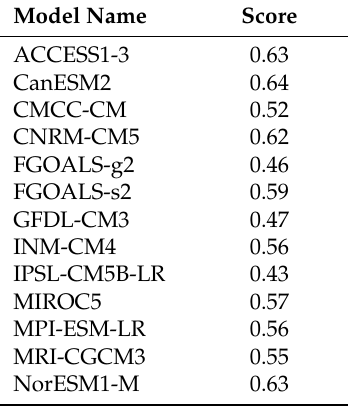
Table 3. The EOF skill score of CMIP5